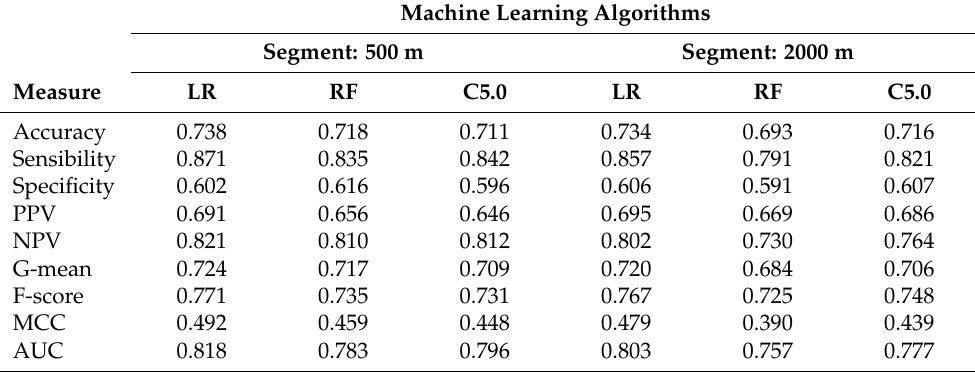
Table 3. Performance measures for the Logistic Regression (LR), Random Forest (RF) and C5.0 algorithms, by road segments length (500 m and 2000 m), for the ROSE